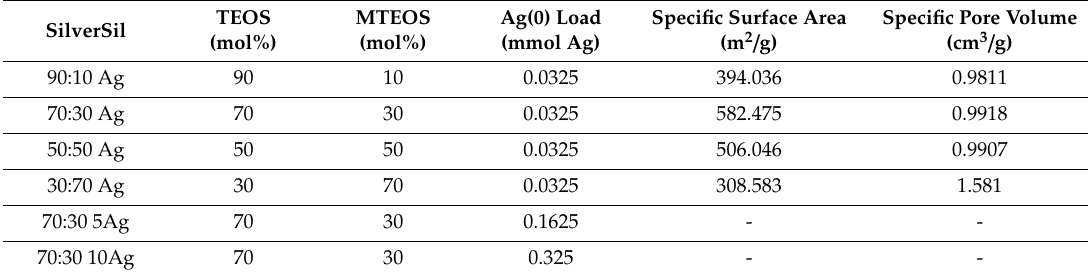
Table 1. Composition of the different SilverSil materials.